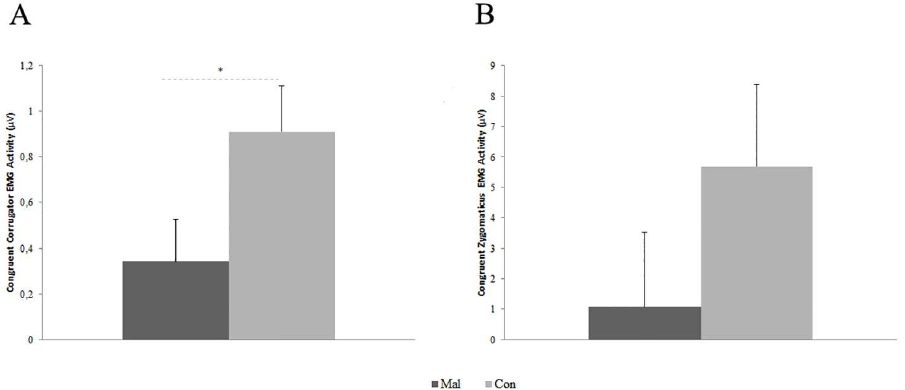
Fig 2. Corrugator and zygomaticus congruent EMG responses to facial expressions of emotions. A) Mean congruent corrugator EMG activity for maltreatedgroup (Mal) and control group (Con) during the visualization of facial expressions of negative emotions. * = p < 0.05. Error bars represent SE. B) Mean congruent zygomaticus EMG activity for maltreated group (Mal) and control group (Con) during the visualization of joy facial